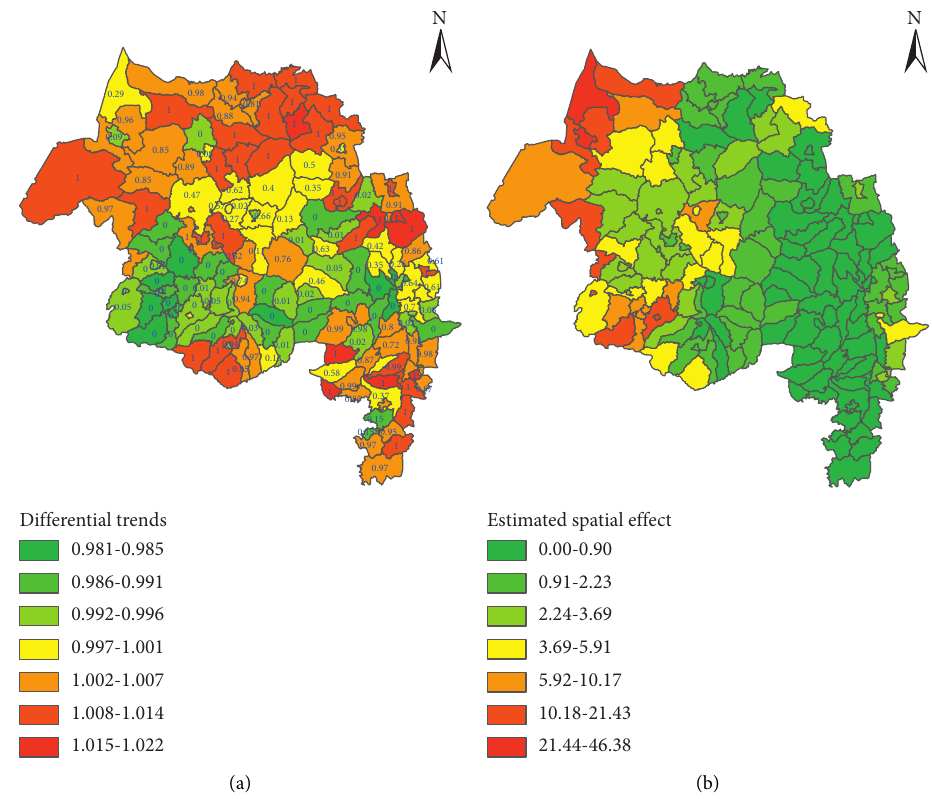
Figure 4: The estimated differential trends of districts with their corresponding posterior probabilities and spatial effects in northwest Ethiopia between 2012 and 2020. (a) Differential trends and the values within the map are posterior probabilities. (b) Estimated spatial effect for each region. Generally, districts shaded in yellow to light orange colors had a lower rate of decreasing trend than the average trend of the region (Figure 4(a)).